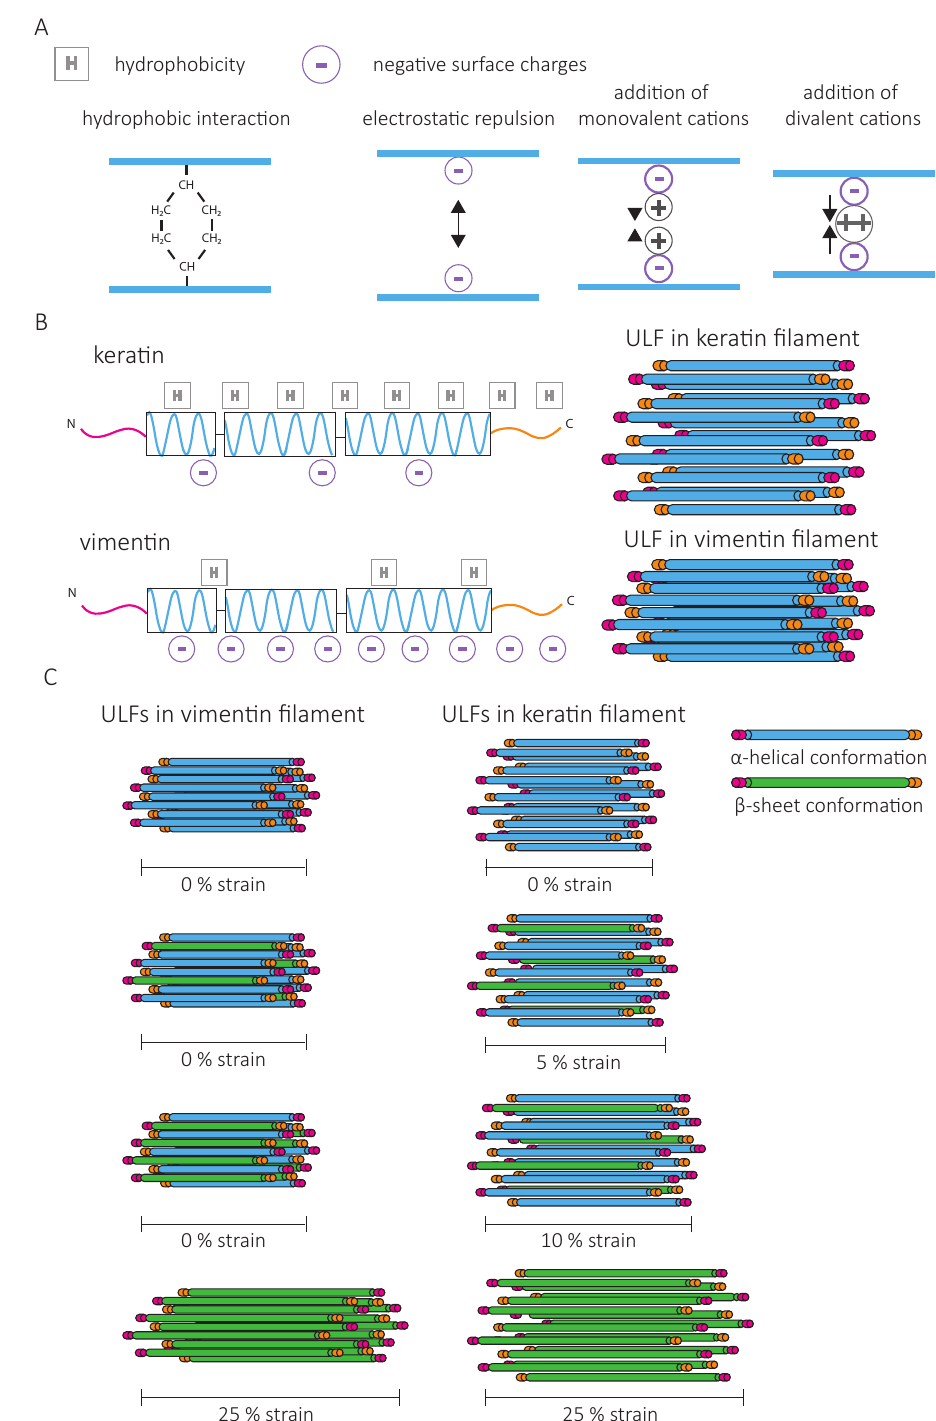
Figure 6. IF subunit interactions and diversity. ( A ). Interactions between intermediate filament proteins result from hydrophobic (H) and electrostatic interactions (circled charges). The presence of cations can tune electrostatic interactions. ( B ). Differences in amino acid sequences between vimentin and keratin account for differences in hydrophobic